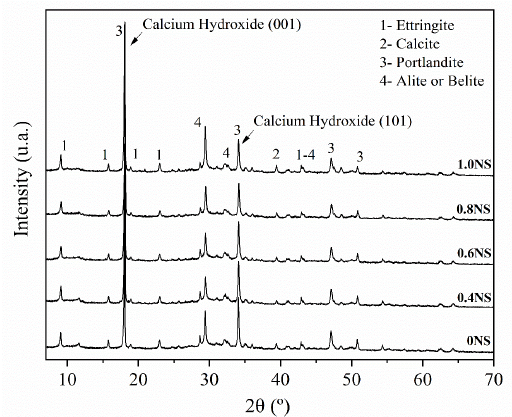
Figure 7. XRD pattern of the cement pastes produced with NS at 28 days of